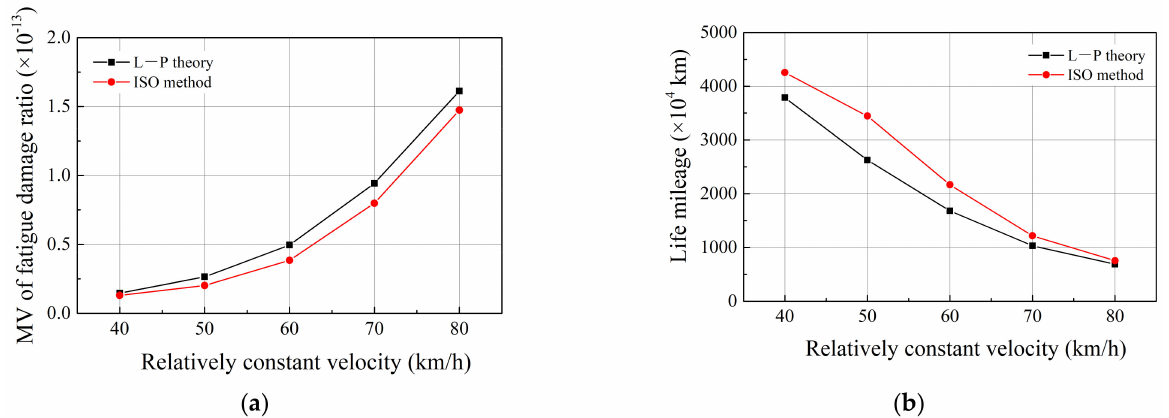
Figure 14. Effect of the relatively constant velocity on fatigue damage of motor bearings: ( a ) variations in MV of fatigue damage ratio and ( b ) life mileage versus the relatively constant